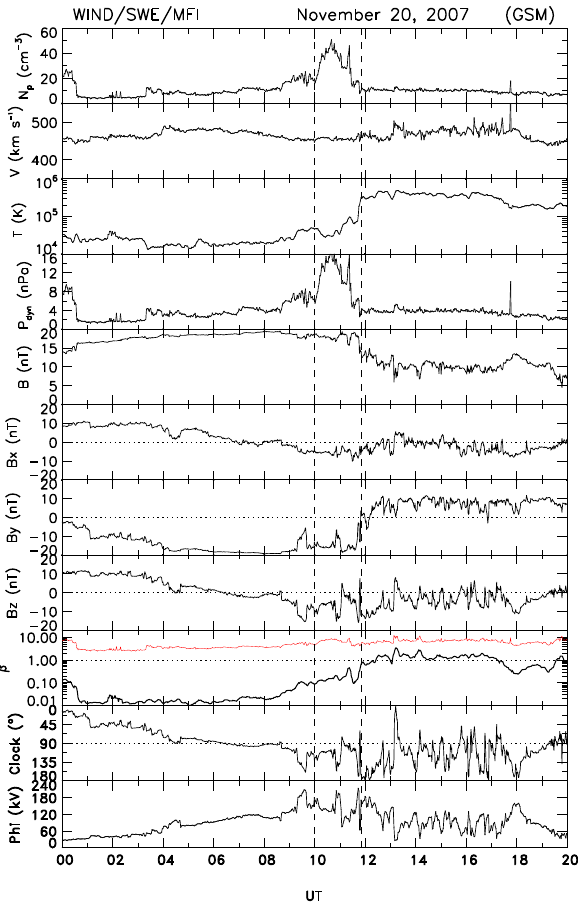
Fig. 9. Wind data for ICME passage at Earth on 20 November 2007. Panels from top to bottom shows: proton density, bulk speed, pro- ton temperature, dynamic pressure, magnetic field components B x , B y , B z , the total field, plasma beta, the clock angle in the GSM Y-Z plane and the Boyle potential. The two vertical guidelines at 10:00 and 11:50UT mark the interval of polar cap ground magnetic deflections we focus on.